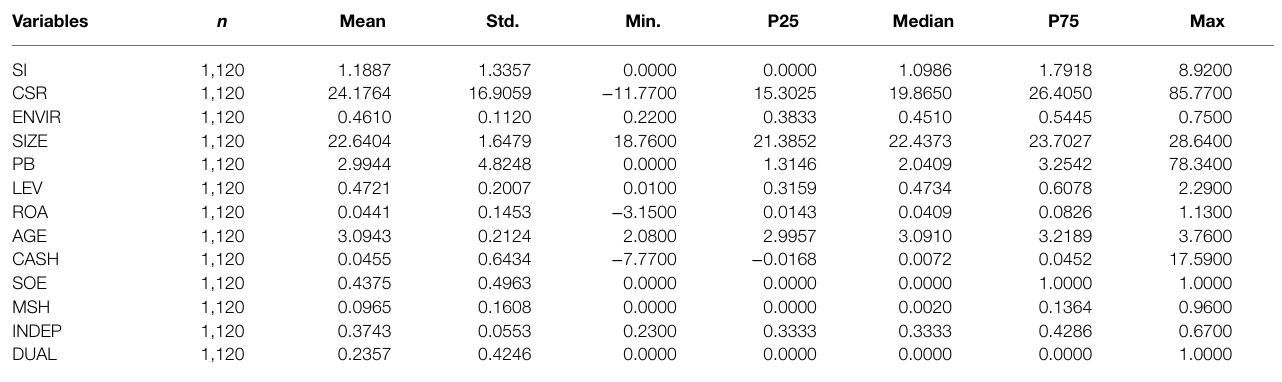
TABLE 2 | Descriptive